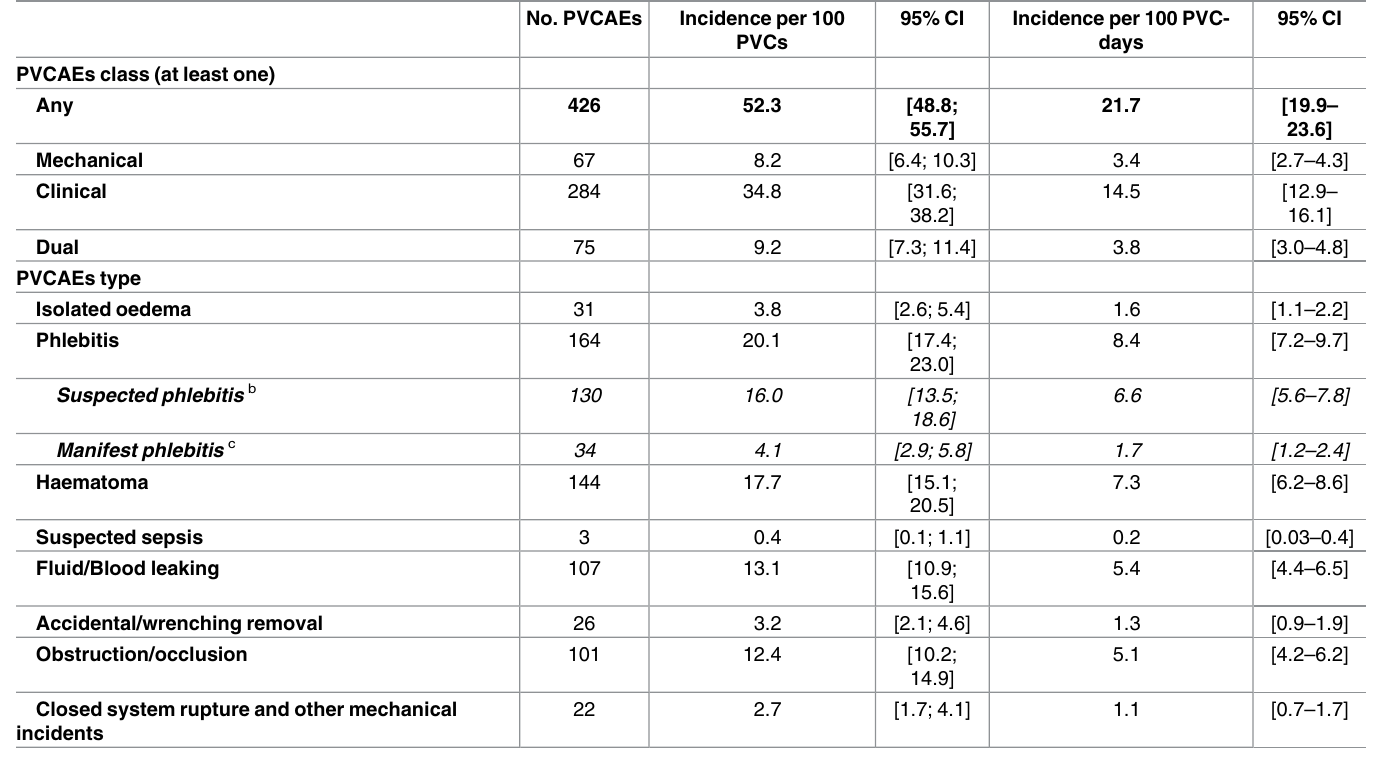
Table 4. Incidence of PVCAEs according to class and type occurring during entire follow-up a , N = 815 PVCs (1964